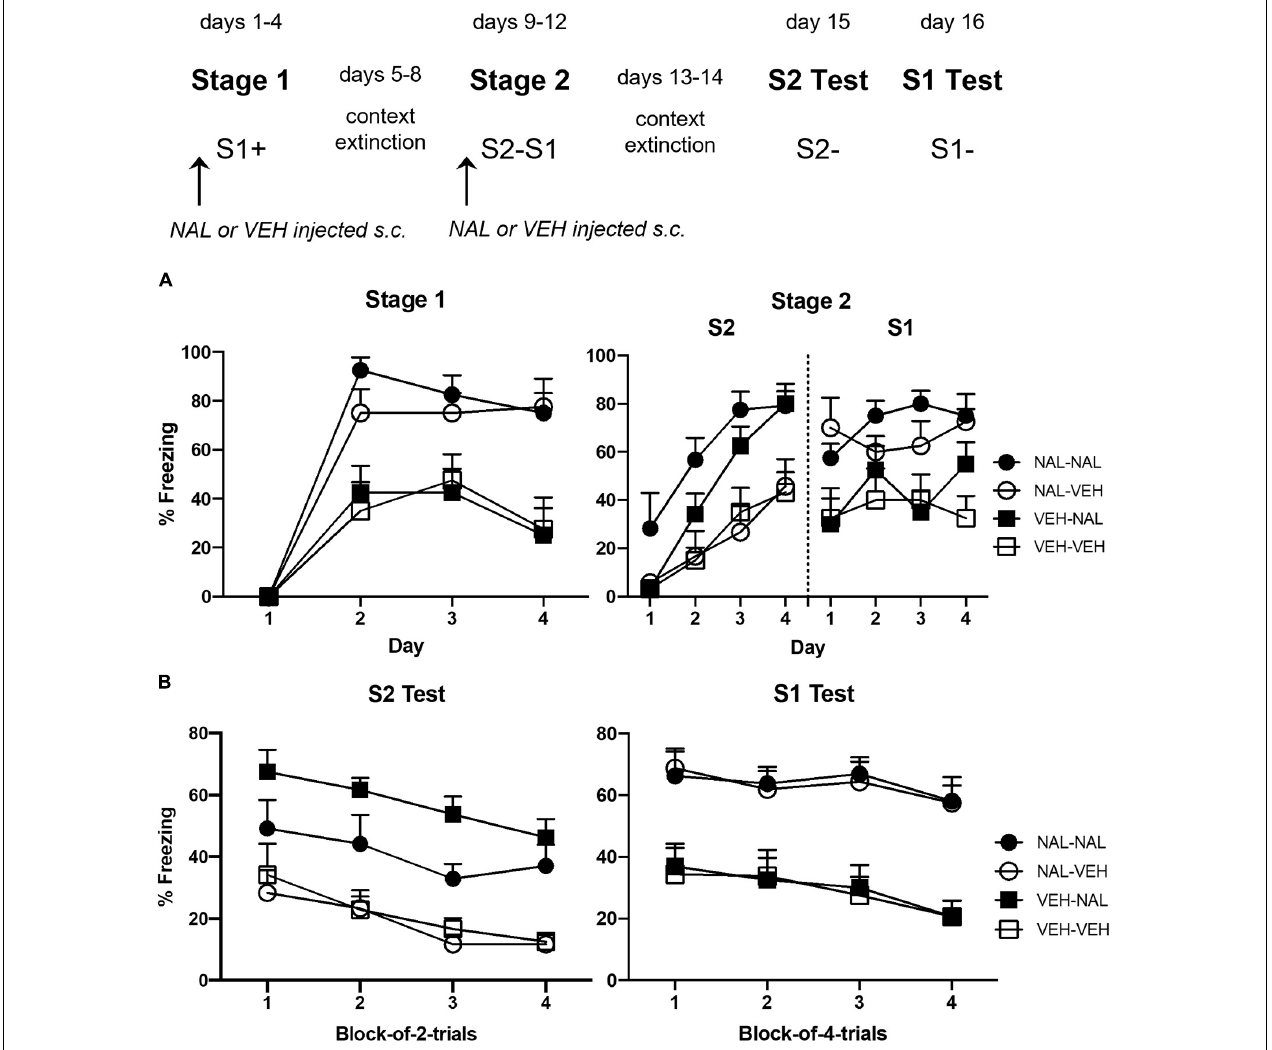
FIGURE 2 | Results of Experiment 1b showing that naloxone enhances the acquisition of first- and second-order conditioned fear. (A) Shows the mean (+ SEM) levels of freezing to S1 in stage 1 (left panel) and to S2 and the previously conditioned S1 in stage 2 (right panel). (B) Shows the mean (+ SEM) levels of freezing during the final drug-free tests across blocks of two S2 alone trials (left panel) and four S1 alone trials (right panel). The numbers of rats in each group were: Group NAL-NAL, n = 8; Group NAL-VEH, n = 8; Group VEH-NAL, n = 8; and Group VEH-VEH, n =